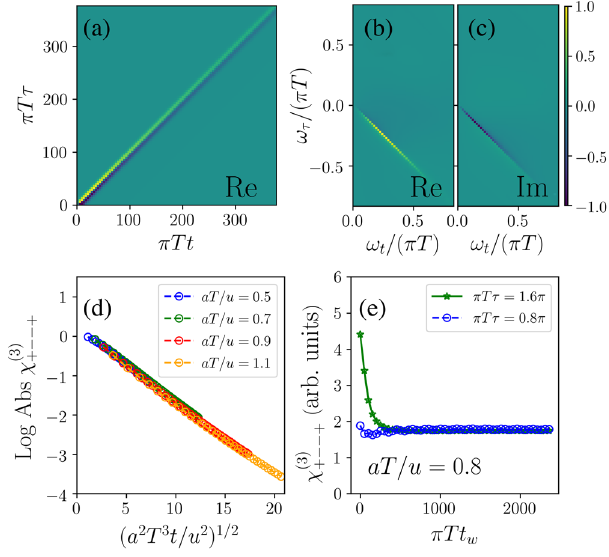
ð 3 Þ FIG. 7. (a) The nonlinear magnetic susceptibility χ þ −− þ as a function of t and τ computed from the harmonic chain model Eq. (28). The waiting time t w ¼ 4 a=u . The temperature T ¼ 1 . 2 u=a . The data are scaled such that the maximum is 1. (b),(c) The real and imaginary parts of the two-dimensional spectrum obtained by Fourier transforming the data in panel (a). Only the first and the fourth quadrants are shown. The other two ð 3 Þ quadrants are obtained by complex conjugation. (d) χ þ −− þ measured at t ¼ τ as a function of ð a 2 Tt=u 2 Þ 1 = 2 for various ð 3 Þ t ¼ τ as a temperatures. t w ¼ 4 a=u . (e) χ þ −− þ measured at function of waiting time t w for two representative values of τ . The temperature T ¼ 0 . 8 u=a